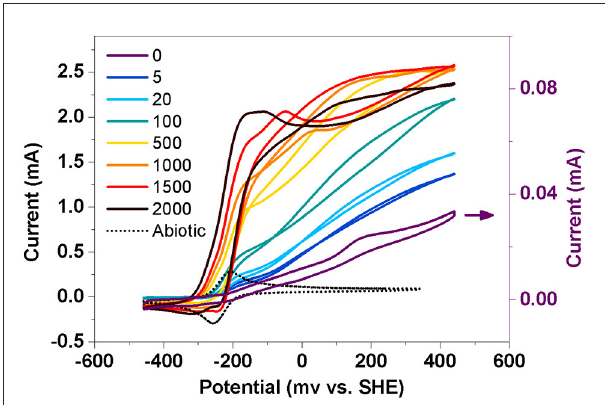
FIGURE3 Slow-scan cyclic voltammetry of biofilm in a bioelectrochemical system (BES) at different AQS concentrations. Abiotic represents a electrochemical system with 50 µ M AQS but without